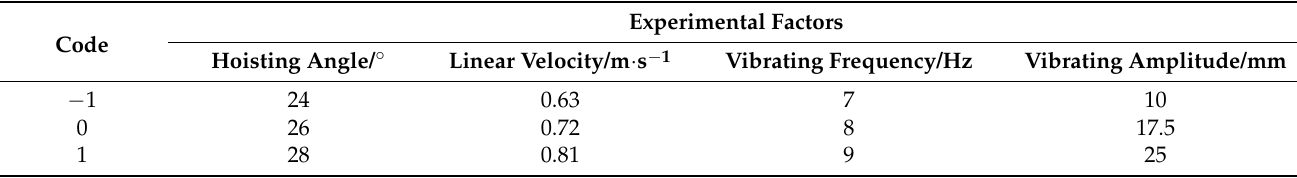
Table 3. Coding of simulation test factors.